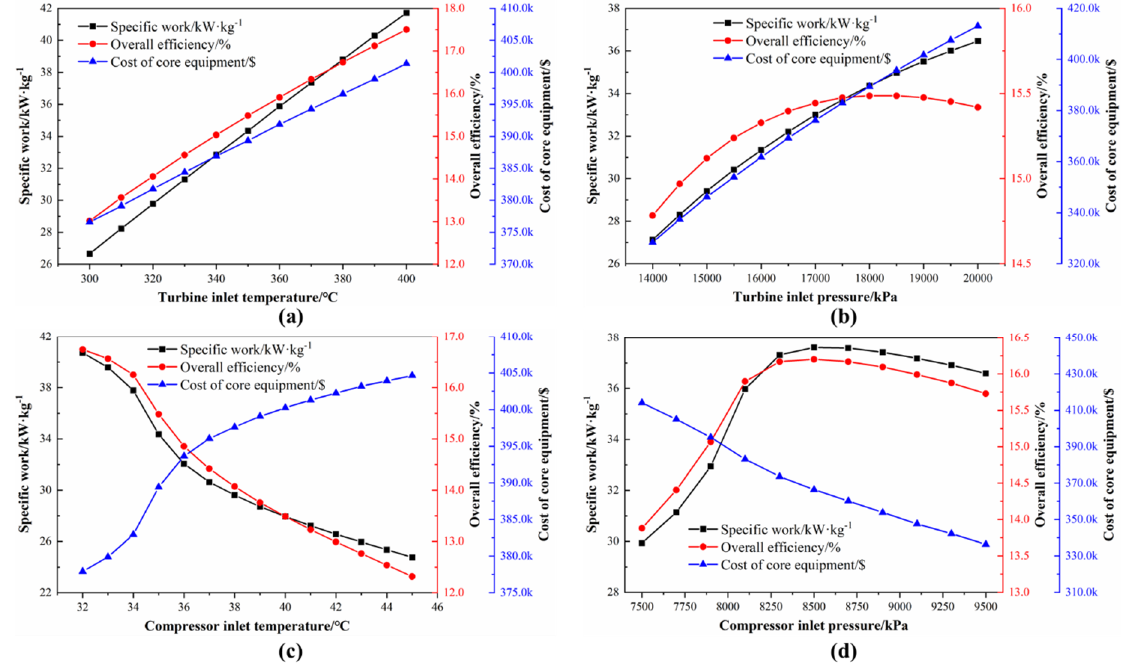
Figure 9. Effects of the turbine inlet temperature ( a ), turbine inlet pressure ( b ), compressor inlet temperature ( c ), and compressor inlet pressure ( d ) on specific work, overall efficiency, and cost of core equipment (recompression cycle).